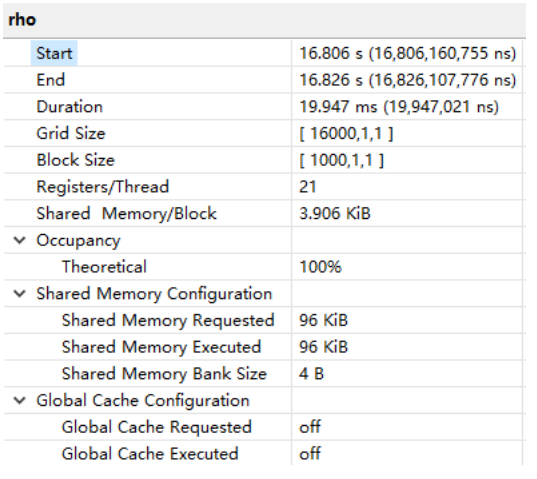
Fig. 10. The GPU kernel properties on calculating the potentials.